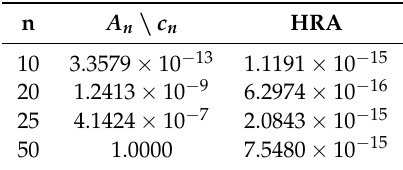
Table 1. Relative errors in solving A n x = c n using the bidiagonal factorization of collocation matrices of Bernstein polynomials (5) and Koev’s